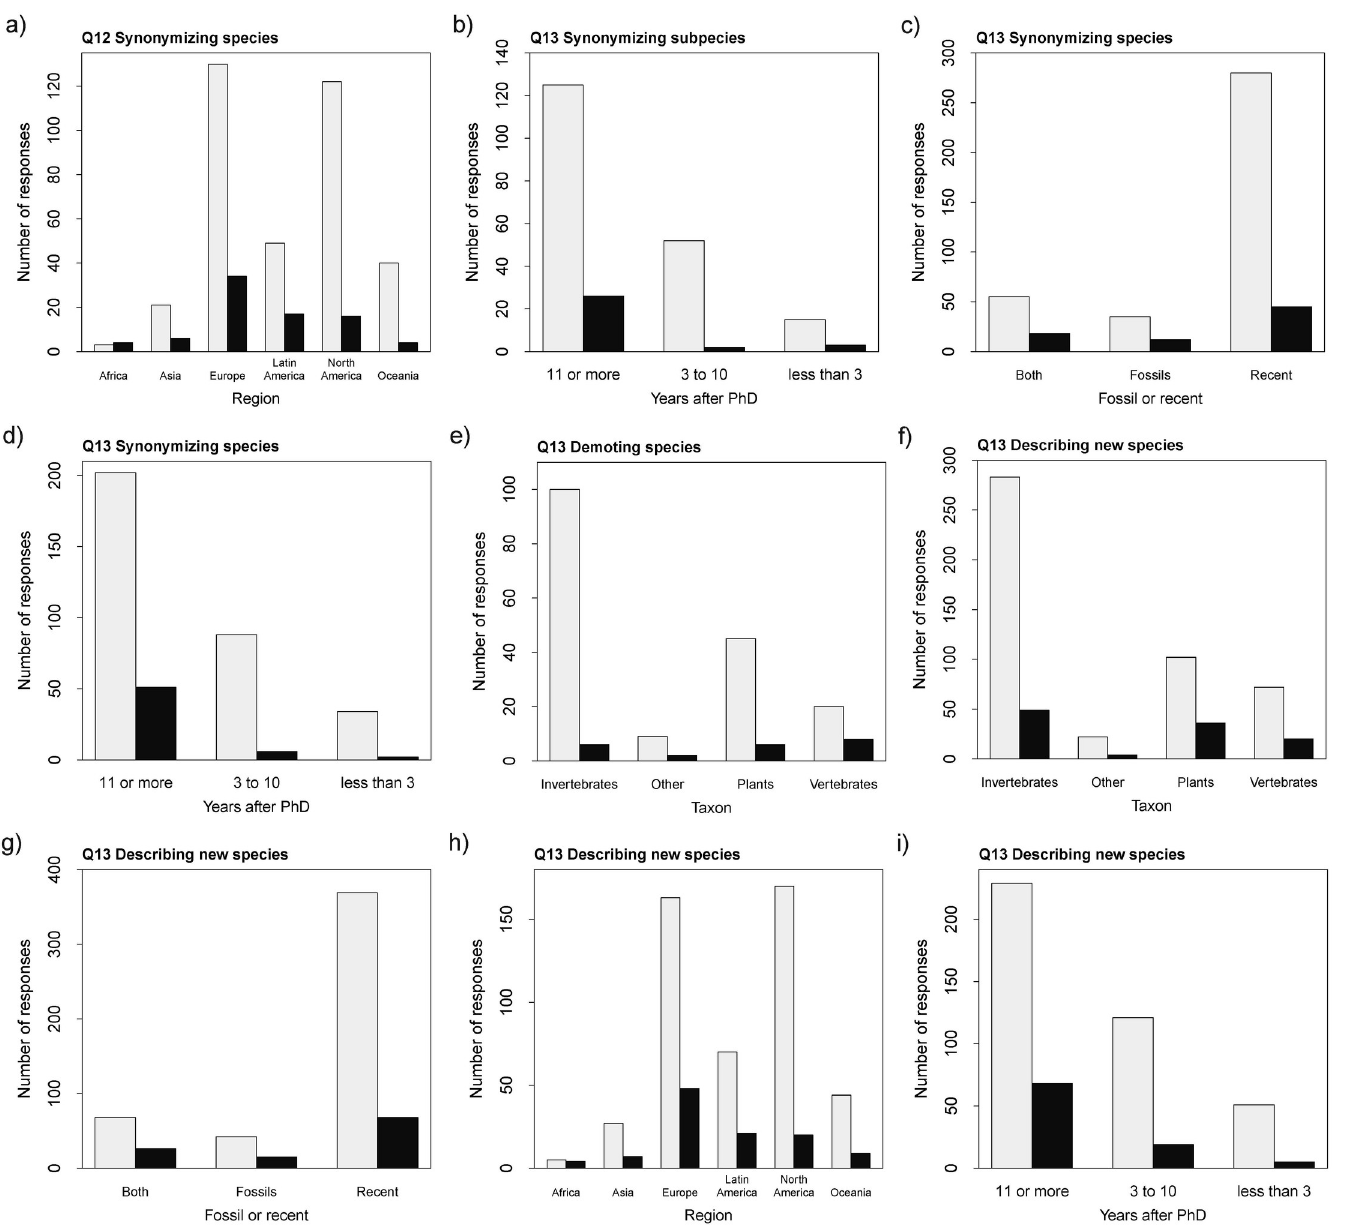
Fig 4. Responses to Q12 and Q13. Number of responses to Q12 and Q13 relative to various characteristics of the study system or respondent, for different types of nomenclatural acts. Yes = black, no = light grey.